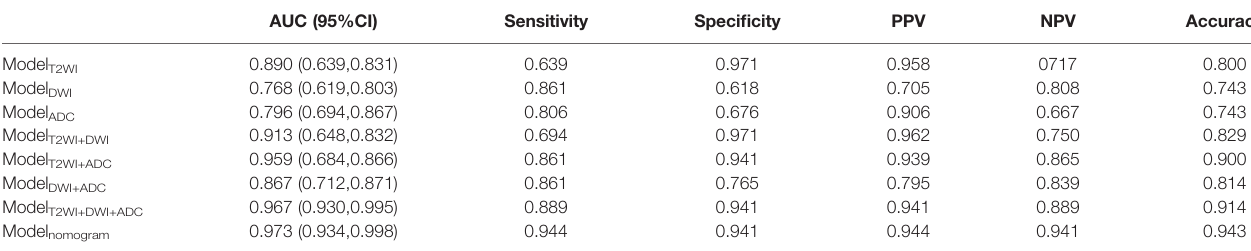
TABLE 3 | Diagnostic performance of all radiomics models and the nomogram.